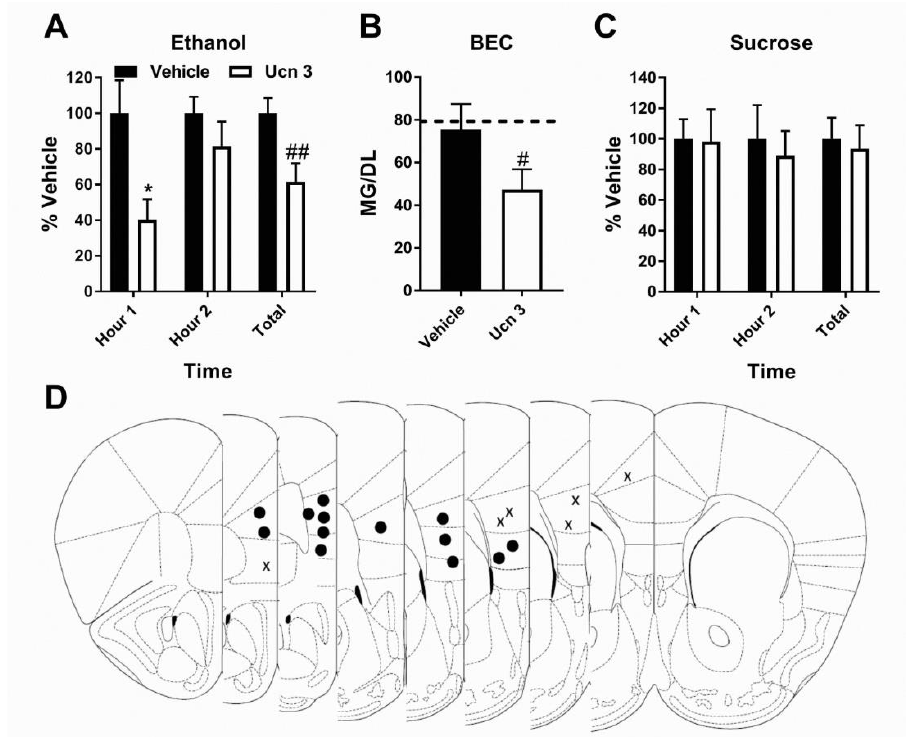
Figure 2. CRF2R agonism in the mPFC specifically blunts binge ethanol intake. ( A ) Urocortin 3 (Ucn3) microinjection into the mPFC significantly reduced ethanol intake and ( B ) final blood ethanol concentration compared to vehicle. ( C ) Ucn3 did alter sucrose intake. ( D ) Cannula placement checks (• = hit N = 13, X = miss N = 6). * = preplanned Bonferroni posthoc test p < 0.05; # = t -test p < 0.05; ## =